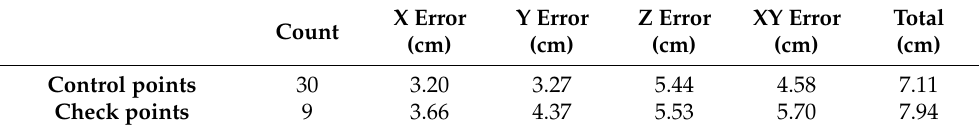
Table 1. Uncertainty values: The RMSE for the control points and check